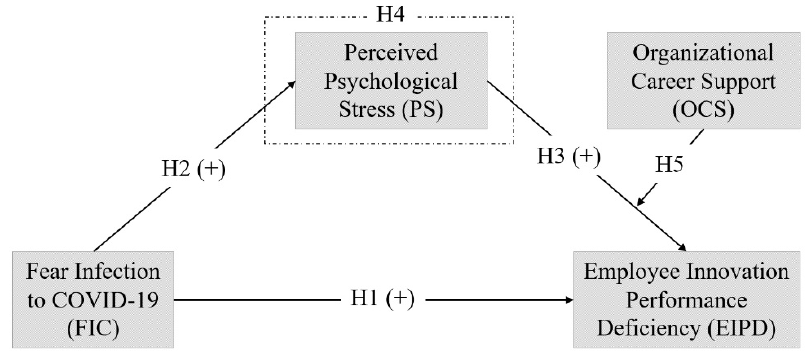
Figure 1. The proposed conceptual framework for the hypothesized relationships.